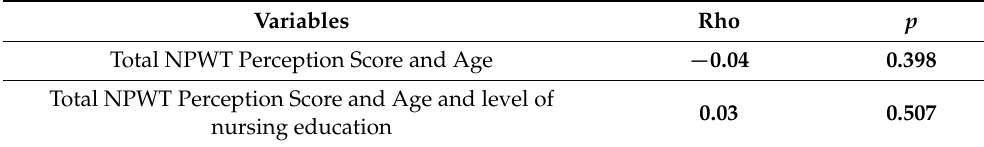
Table 7. Assessment of the relationship between the level of knowledge and the level of motivation and readiness to implement NPWT. Variables Rho p Knowledge (domain I) and motivation to use 0.63 <0.001 NPWT (domain II) Knowledge (domain I) and readiness to use 0.47 <0.001 NPWT (domain III)